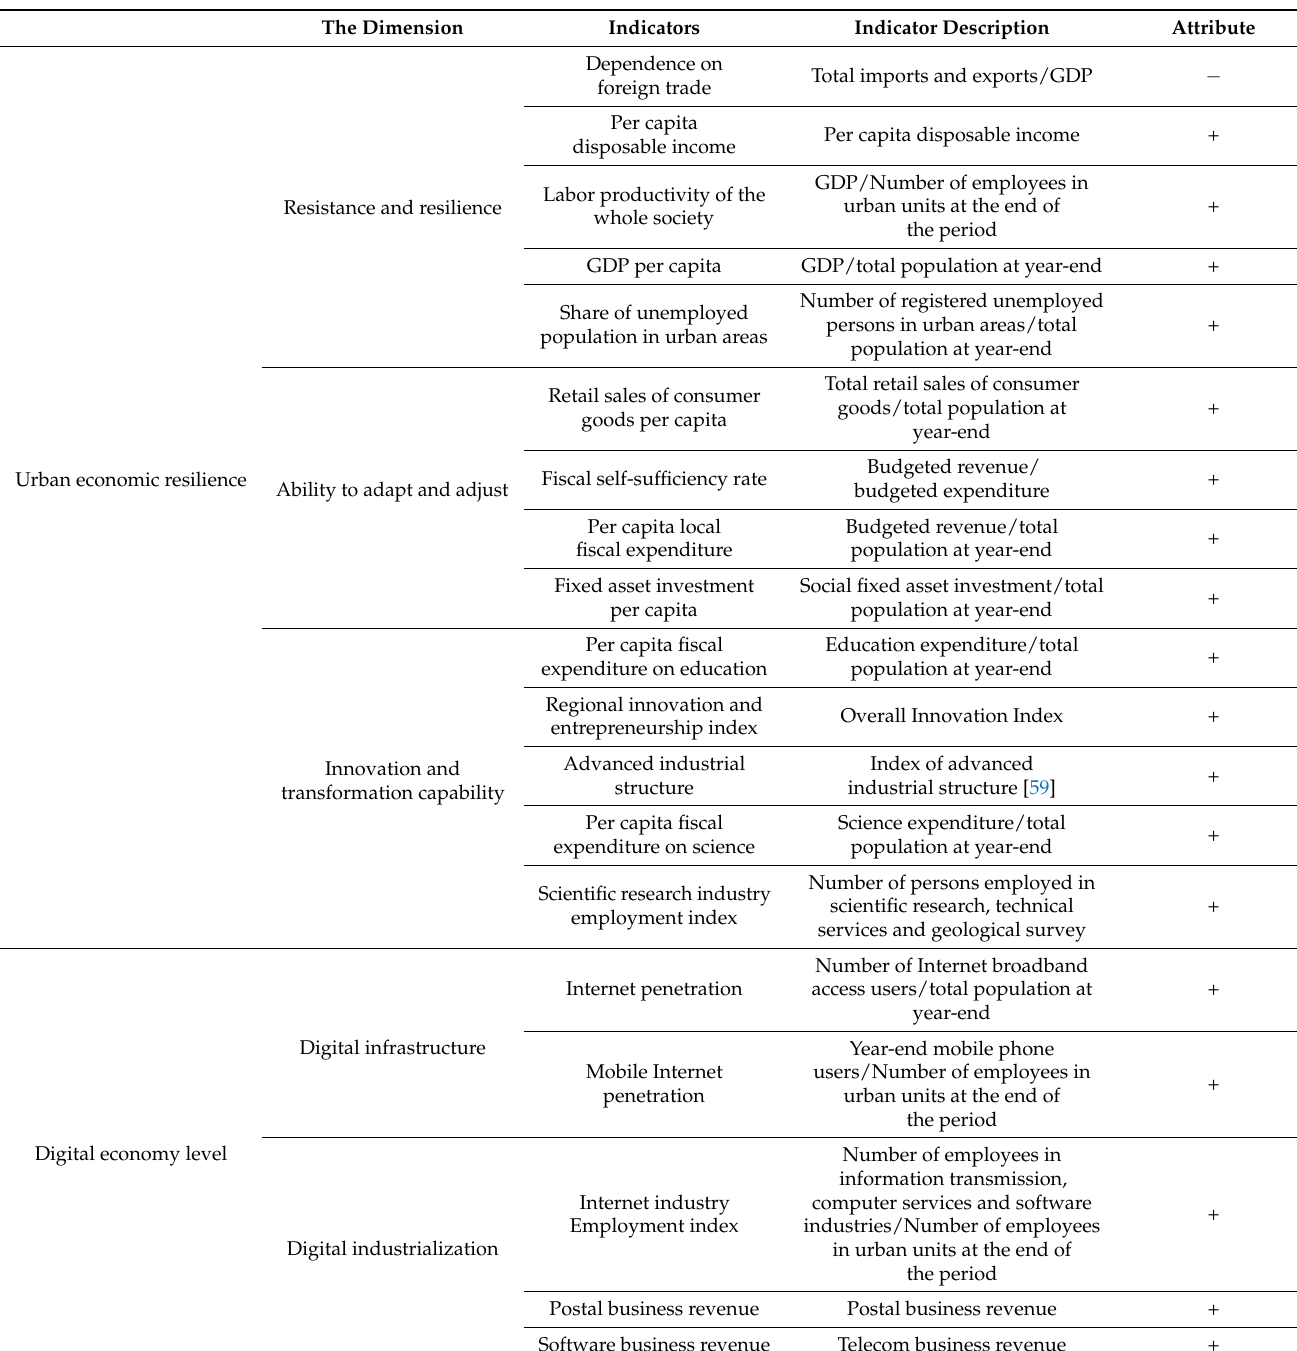
Table 1. Comprehensive evaluation system of urban economic resilience and digital economy level. The